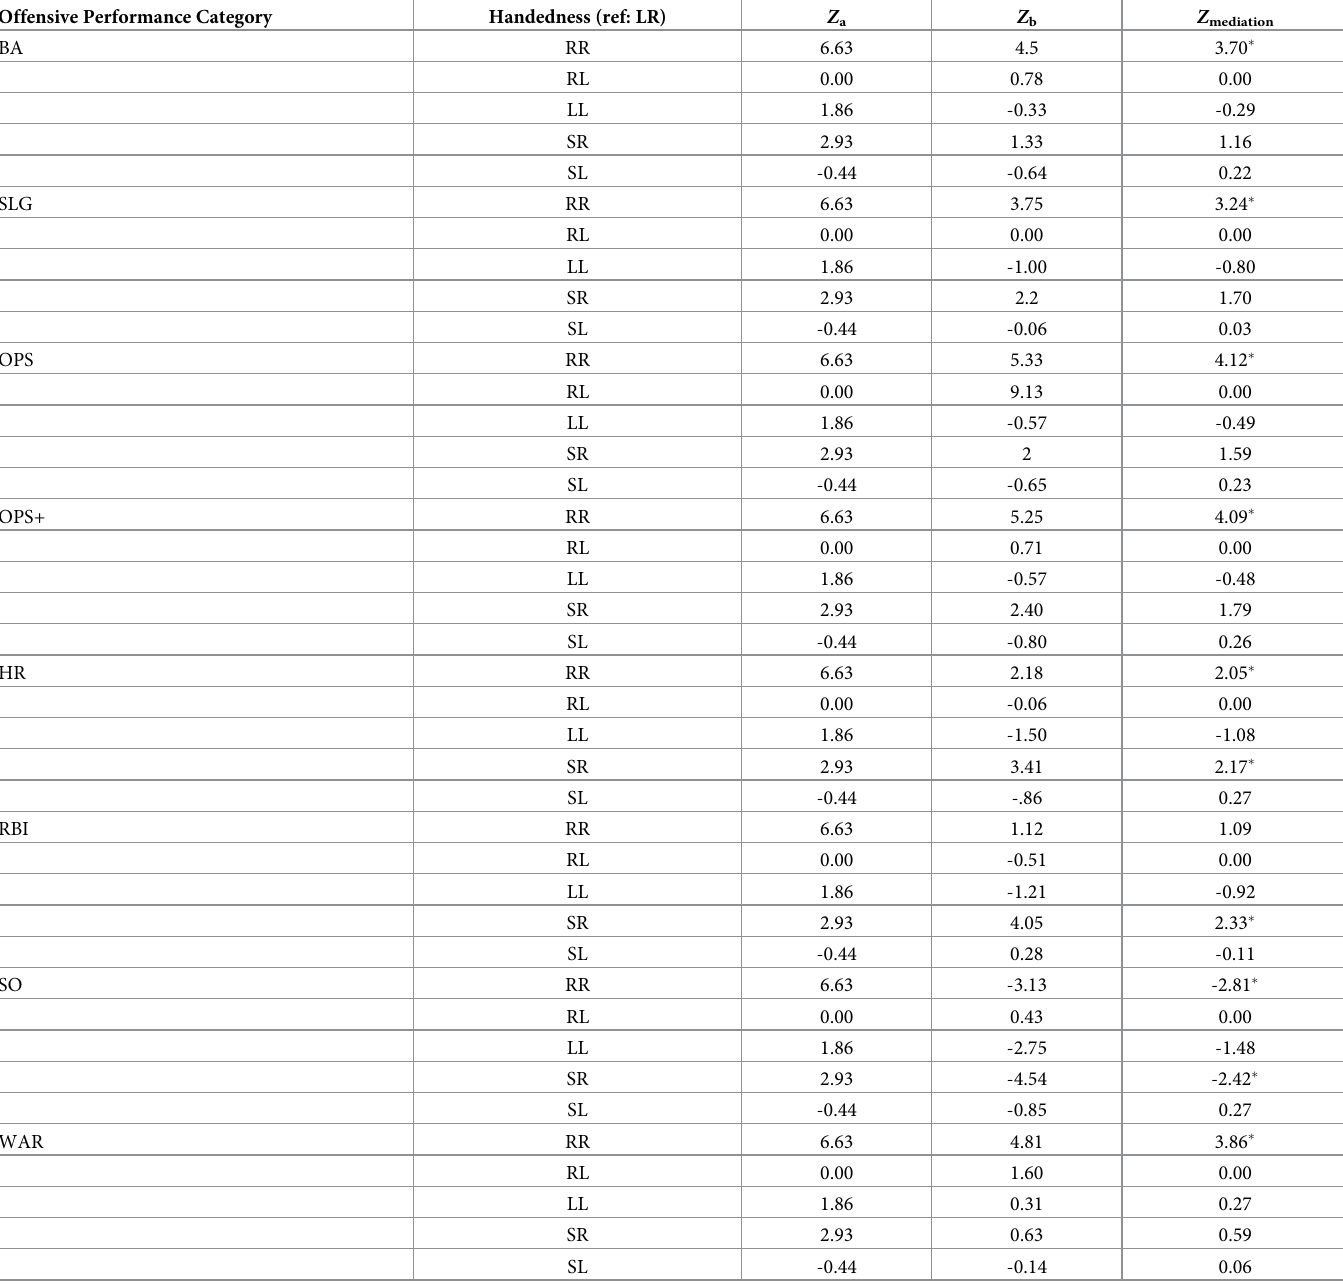
Table 5. Mediation analyses of birthplace (Canada vs. World) on offensive performance through handedness (Bats left, throws right vs. bats right, throws right; bats right, throws left; bats left, throws left; bats left and right, throws right; bats left and right, throws left). Offensive Performance